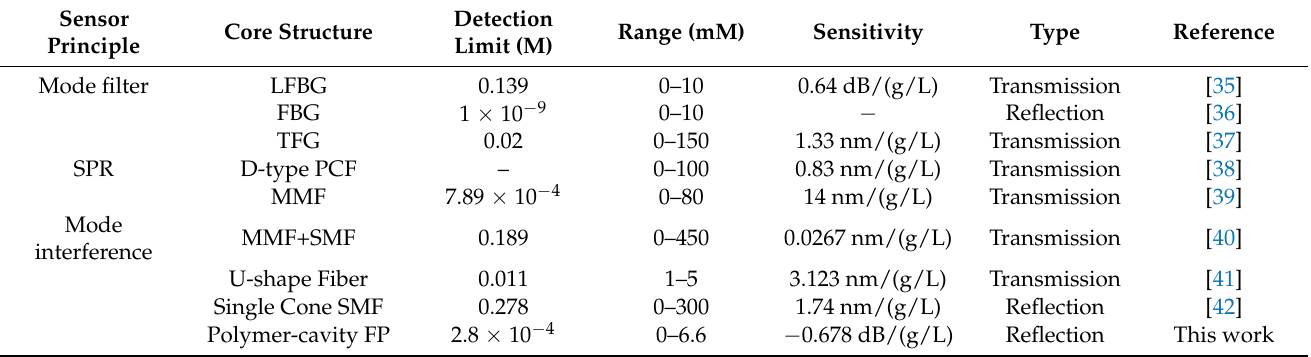
Table 1. Performance comparison of optic fiber glucose sensors reported in recent